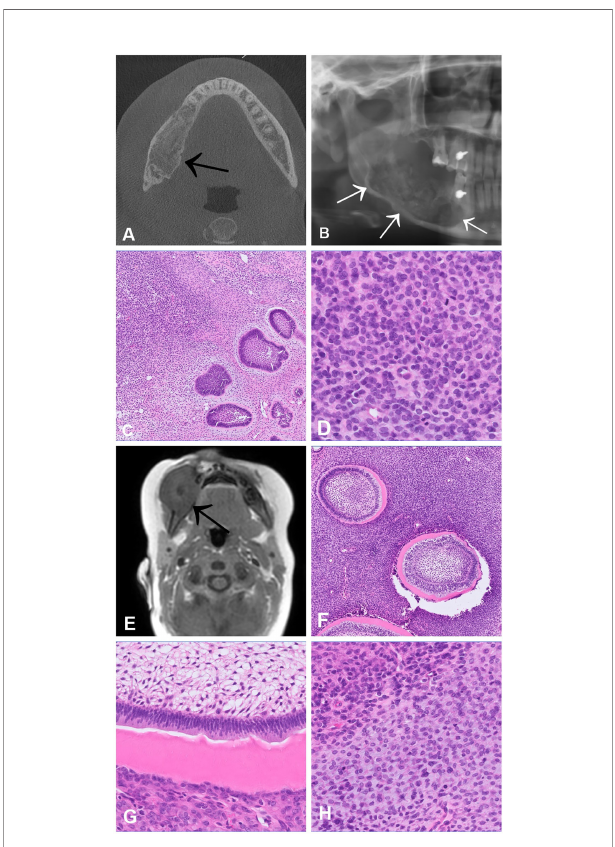
FIGURE 6 | Ameloblastic fi brosarcoma (A – D) and Ameloblastic fi bro- dentinosarcoma (E – H) . CT scan (A) and OPG (B) showing an osteodestructive mass affecting the entire right horizontal mandibular branch in fi ltrating the lingual and vestibular cortex. (C, D) Histologically, the tumour is biphasic and consists of an ameloblastoma-like epithelial proliferation embedded in a hypercellular stroma, which alternates with more hypocellular areas. In the cell-rich component of the stroma, high mitotic activity and nuclear atypia are present (D) . (E) MRI scan of an ameloblastic fi bro- dentinosarcoma documenting an expansile mass in the region of the right mandible, which breaches the cortex and extends into the adjacent structures. (F, G) Histologically, the tumour shows a biphasic appearance with an ameloblastoma-like epithelial component with aberrant dentin formation. (H) The ectomesenchymal component consists of a hypercellular spindle cell stroma in which cytological atypia and increased mitotic activity can be